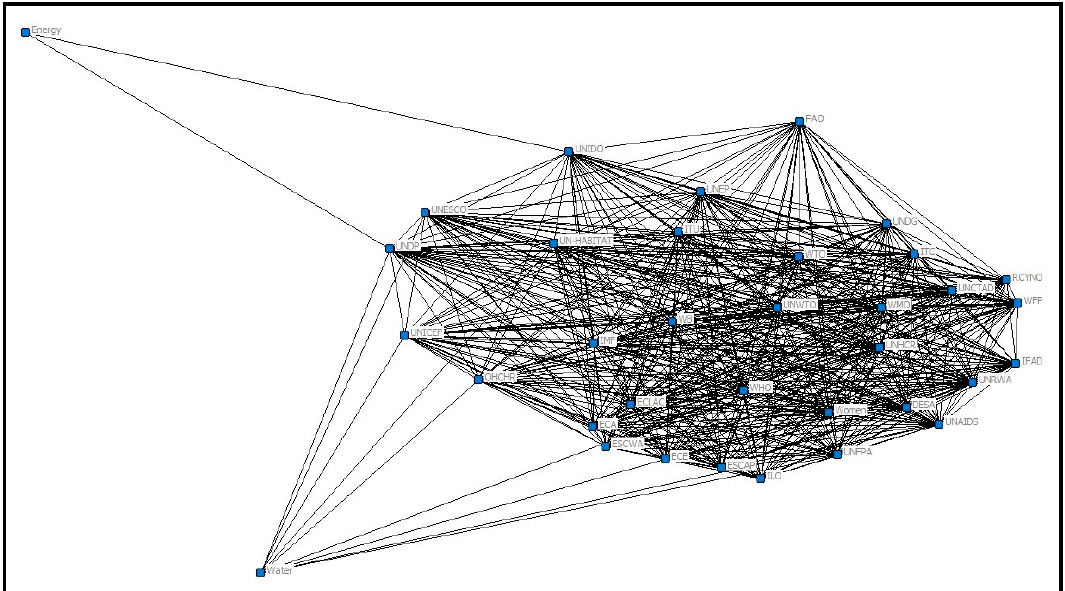
Figure 2 . Organizations—Food–Energy–Water (FEW) and partnership network.